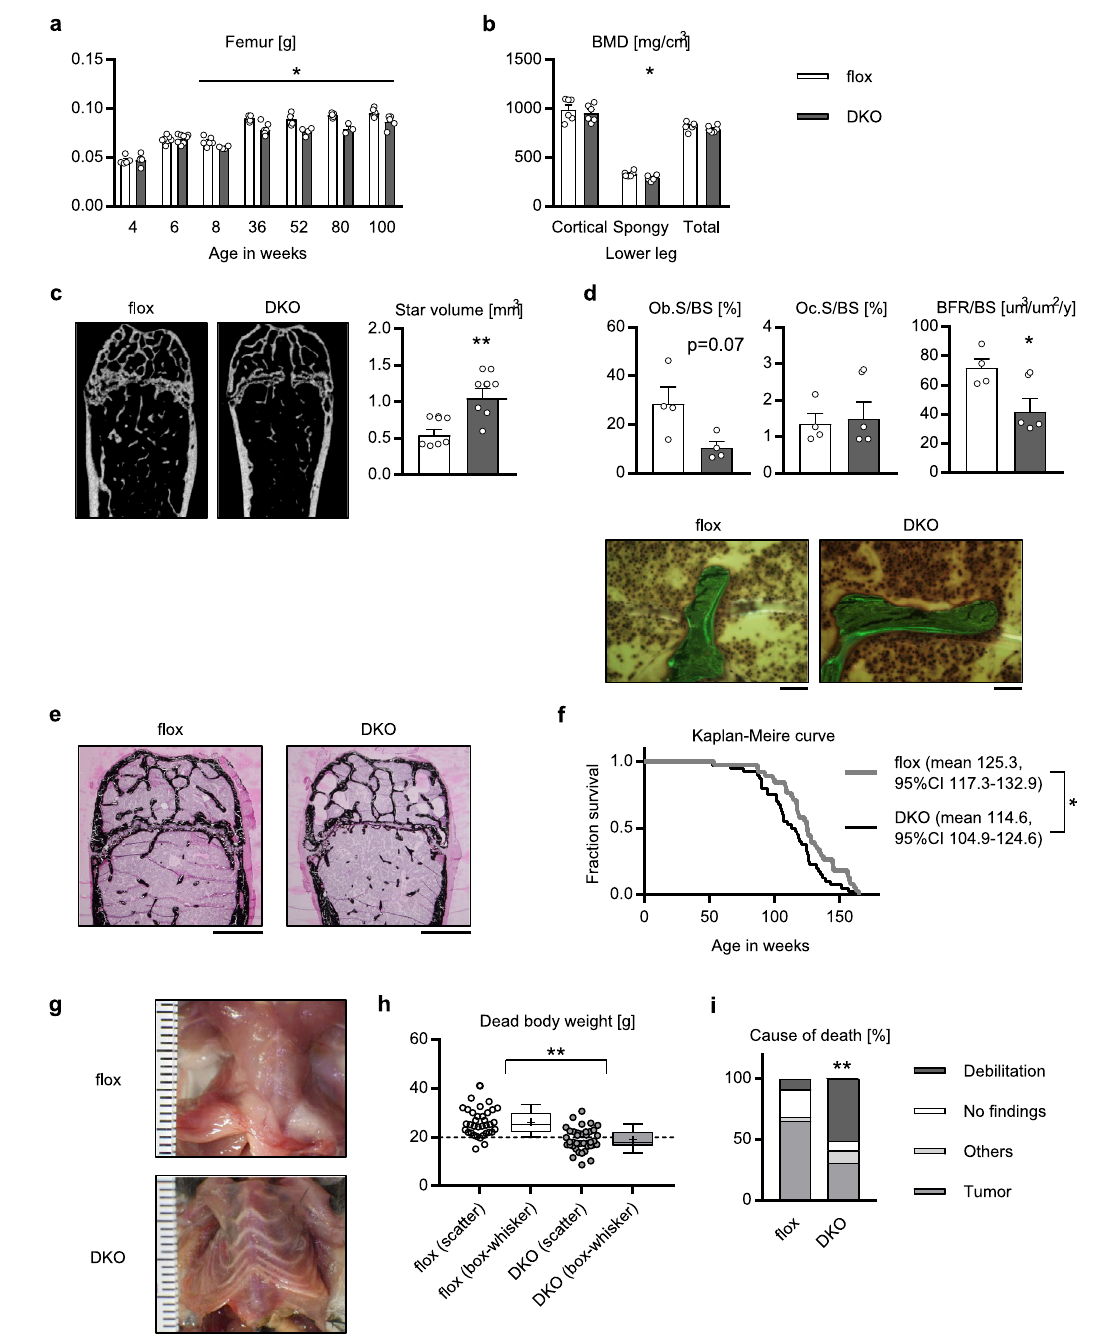
Fig. 5 | Bone-associated and systemic phenotypes of the mAktDKO mice. a FemurweightofthemAktDKOmiceattheageoftheindicatedweeks( n =3,4,5,6, 7,or8micepergroup,asshownbythenumberofdatapointsonthegraph,sameas below). b Bone mineral density of lower legs at the age of 40 weeks analyzed by CT scanning ( n =6 mice). c , Analysis of osteoporosis by micro-CT scanning of femur at the age of 52 weeks ( n =6 mice). Scale bars: 500 μ m. d Morphometric analysis of calcein-labeled femur at the age of 52 weeks ( n =4 mice). Ob.S/BS: osteoblast sur- face/bone surface, Oc.S/BS: osteoclast surface/bone surface, BFR/BS: bone forma- tionrate/bonesurface.Scalebars:50 μ m. e vonKossastainingoffemurattheageof